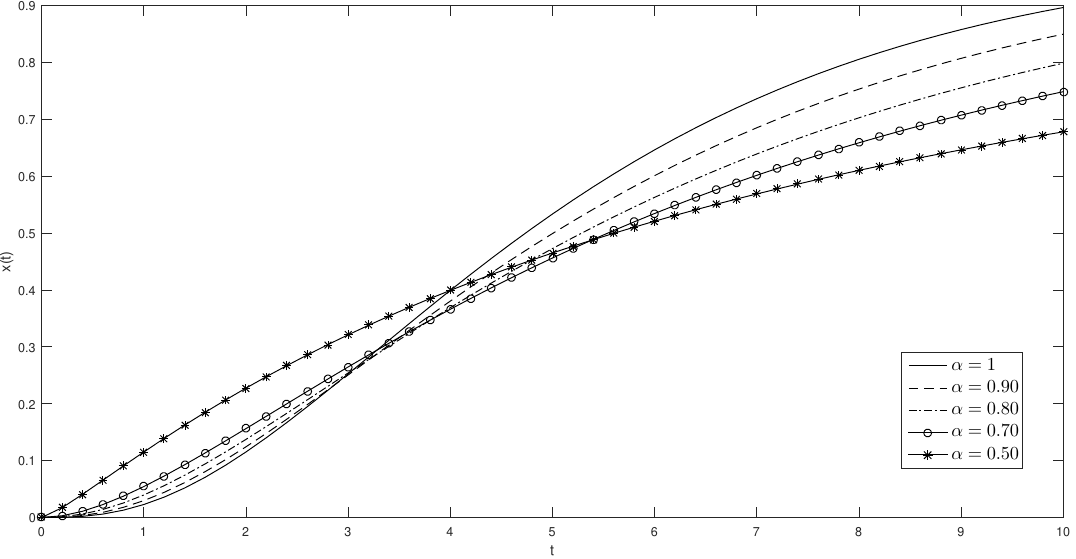
Figure 3. The solution of Equation (35) considering x 0 = 0 and several values of α